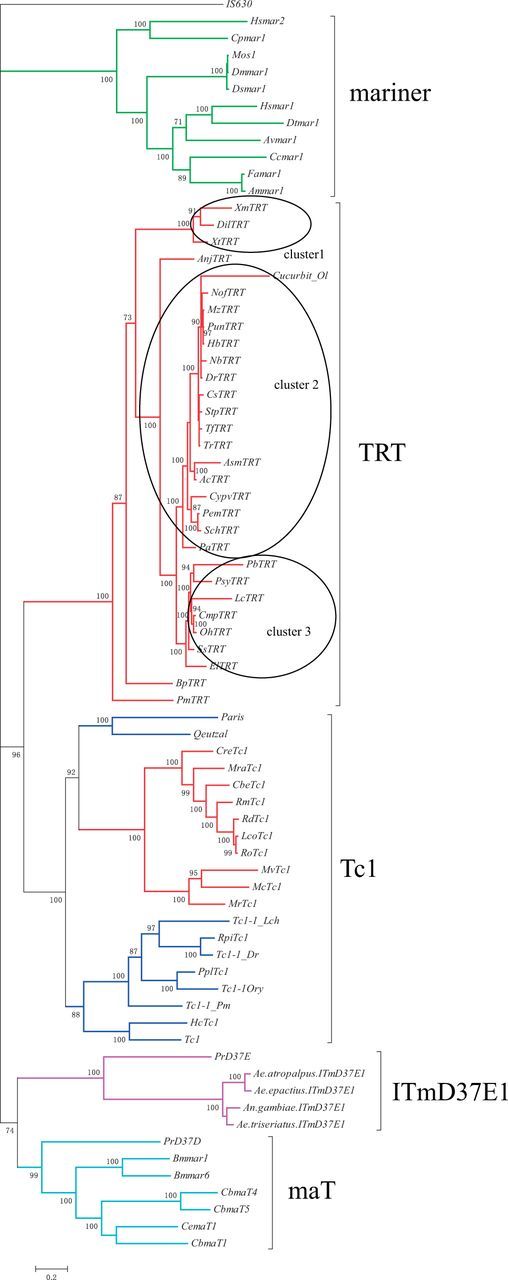
Phylogenetic relationships of all TRT and Tc1 elements identified in this study with other members of the Tc1/mariner superfamily based on their transposases. Bootstrap values of <70% are not shown. Three clusters of TRT elements might be involved in HTs were circled up in circles. TRT and Tc1 elements identified in this study were shown using red color.